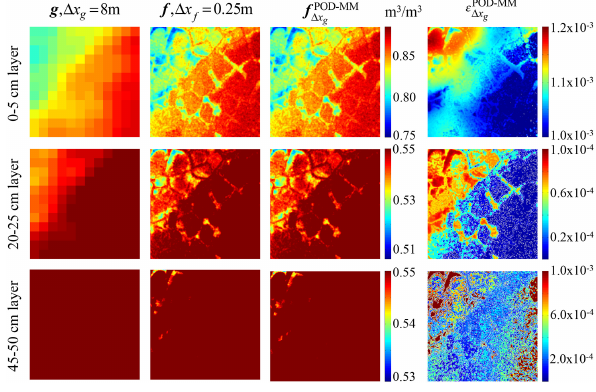
Figure 10. Solutions of f , g , and ε POD - MM for day 106 for year 1x g 2002 at site D and for three soil depths; the top, middle, and bottom rows correspond to layers 0–5, 20–25, and 45–50cm, respectively, from the surface. Regions with homogeneous red color in the panels reflect the fact that large regions of the solutions are